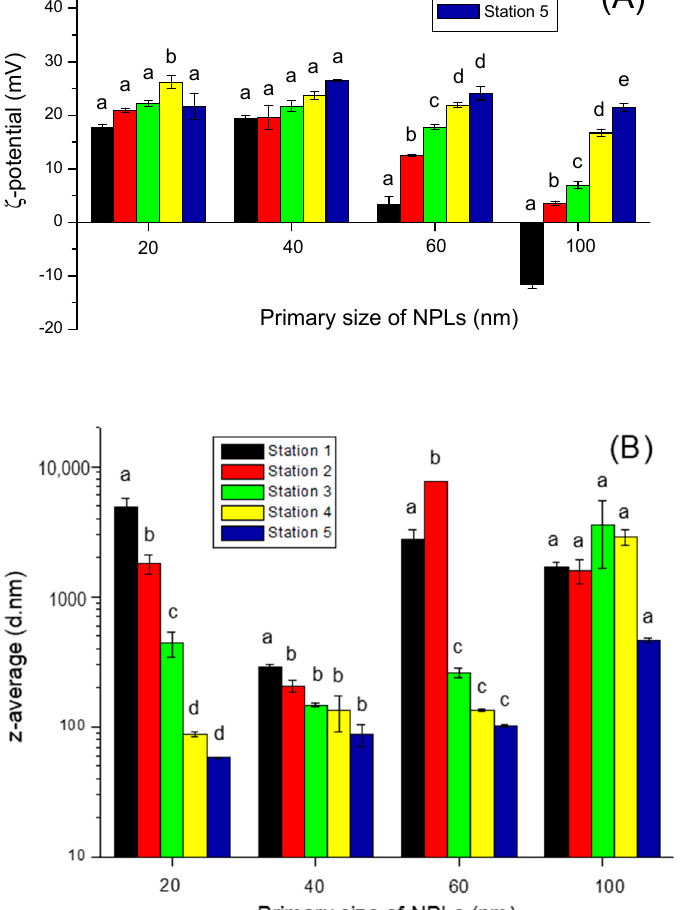
Figure 2. ( A ) ζ -Potentials and ( B ) z-average diameters of polystyrene nanoplastics (NPLs) as a function of primary sizes in freshwaters at marsh–lake transect “Pointe- à -la-Bise”. NPL concentration is equal to 50 mg/L, and from Station 1 to Station 5, DOC concentration is equal to 1.681, 1.515, 1.326, 1.116, and 0.8795 mg/L, respectively. Letters (a,b,c,d) indicate statistically significant difference between treatments (pairwise multiple comparison procedures—Tukey’s test within each NPL size group, p -value < 0.05).